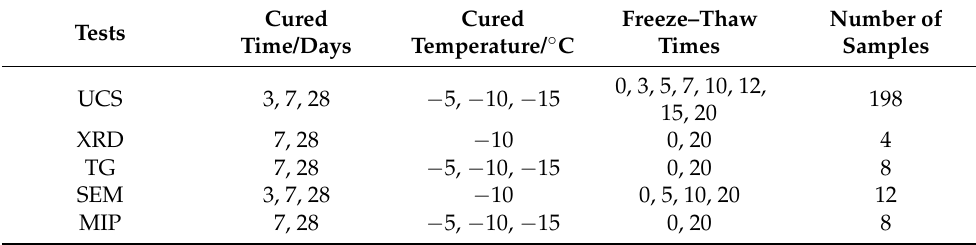
Table 3. Test plan for